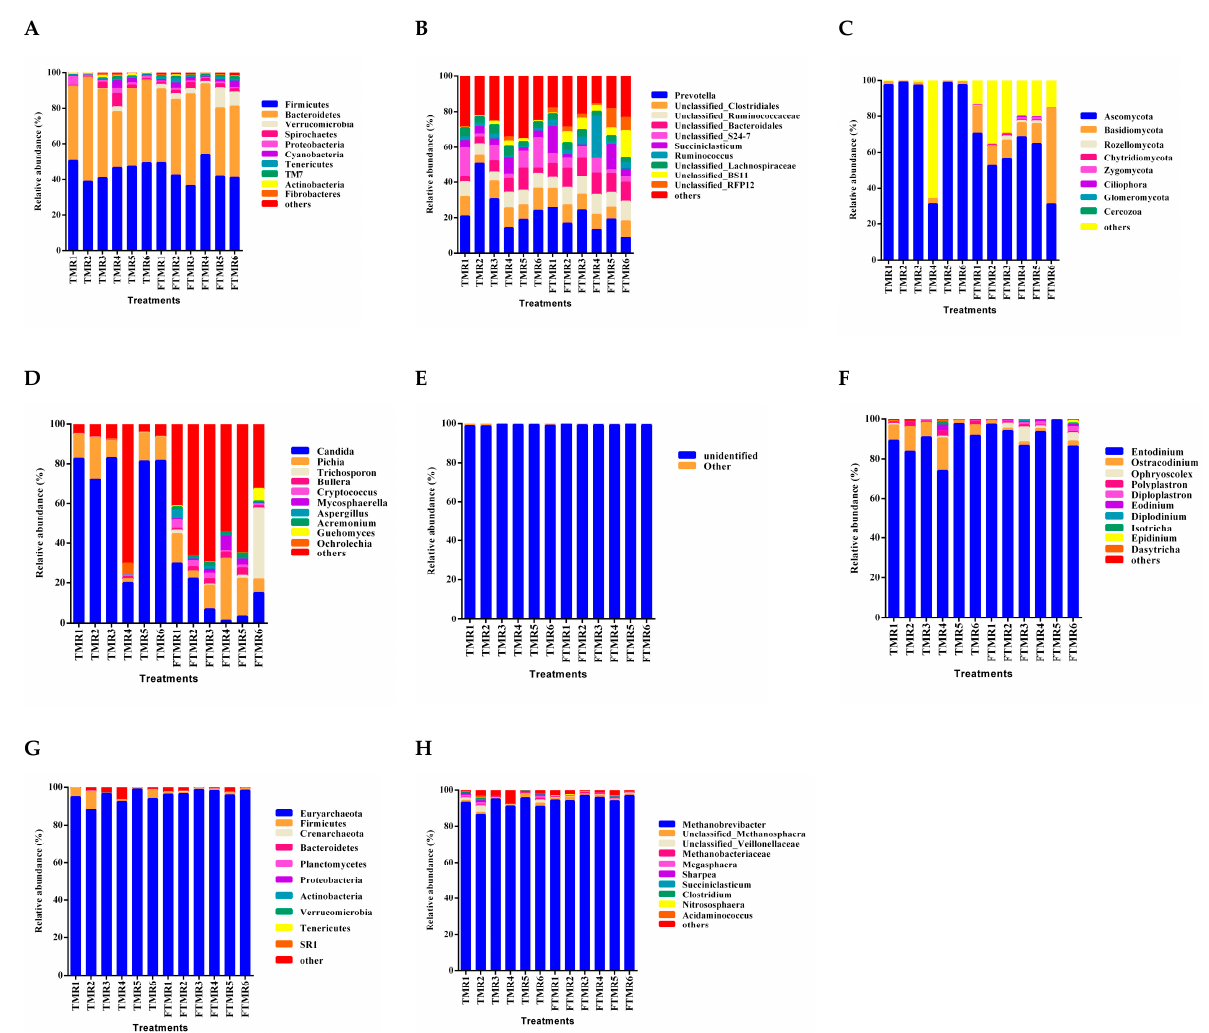
Figure 5. Relative abundance of microbial phyla and genera in the TMR and FTMR. The abundance of the bacteria phyla ( A ), anaerobic fungi ( C ), protozoa ( E ), and archaea ( G ); abundance of genera of bacteria ( B ), anaerobic fungi ( D ), protozoa ( F ), and archaea ( H ). Only the top 10 phyla and genera in abundance are shown in the figure; other species were combined as “others”. TMR, total mixed ration; FTMR, fermentation total mixed ration. Table 3. The diversity of main rumen microbiota that significantly changed in the phyla and genera level between the TMR and FTMR in dairy cows. (accounting for ≥ 1% of the total sequences in the abundance of top 10 genera in at least one of the